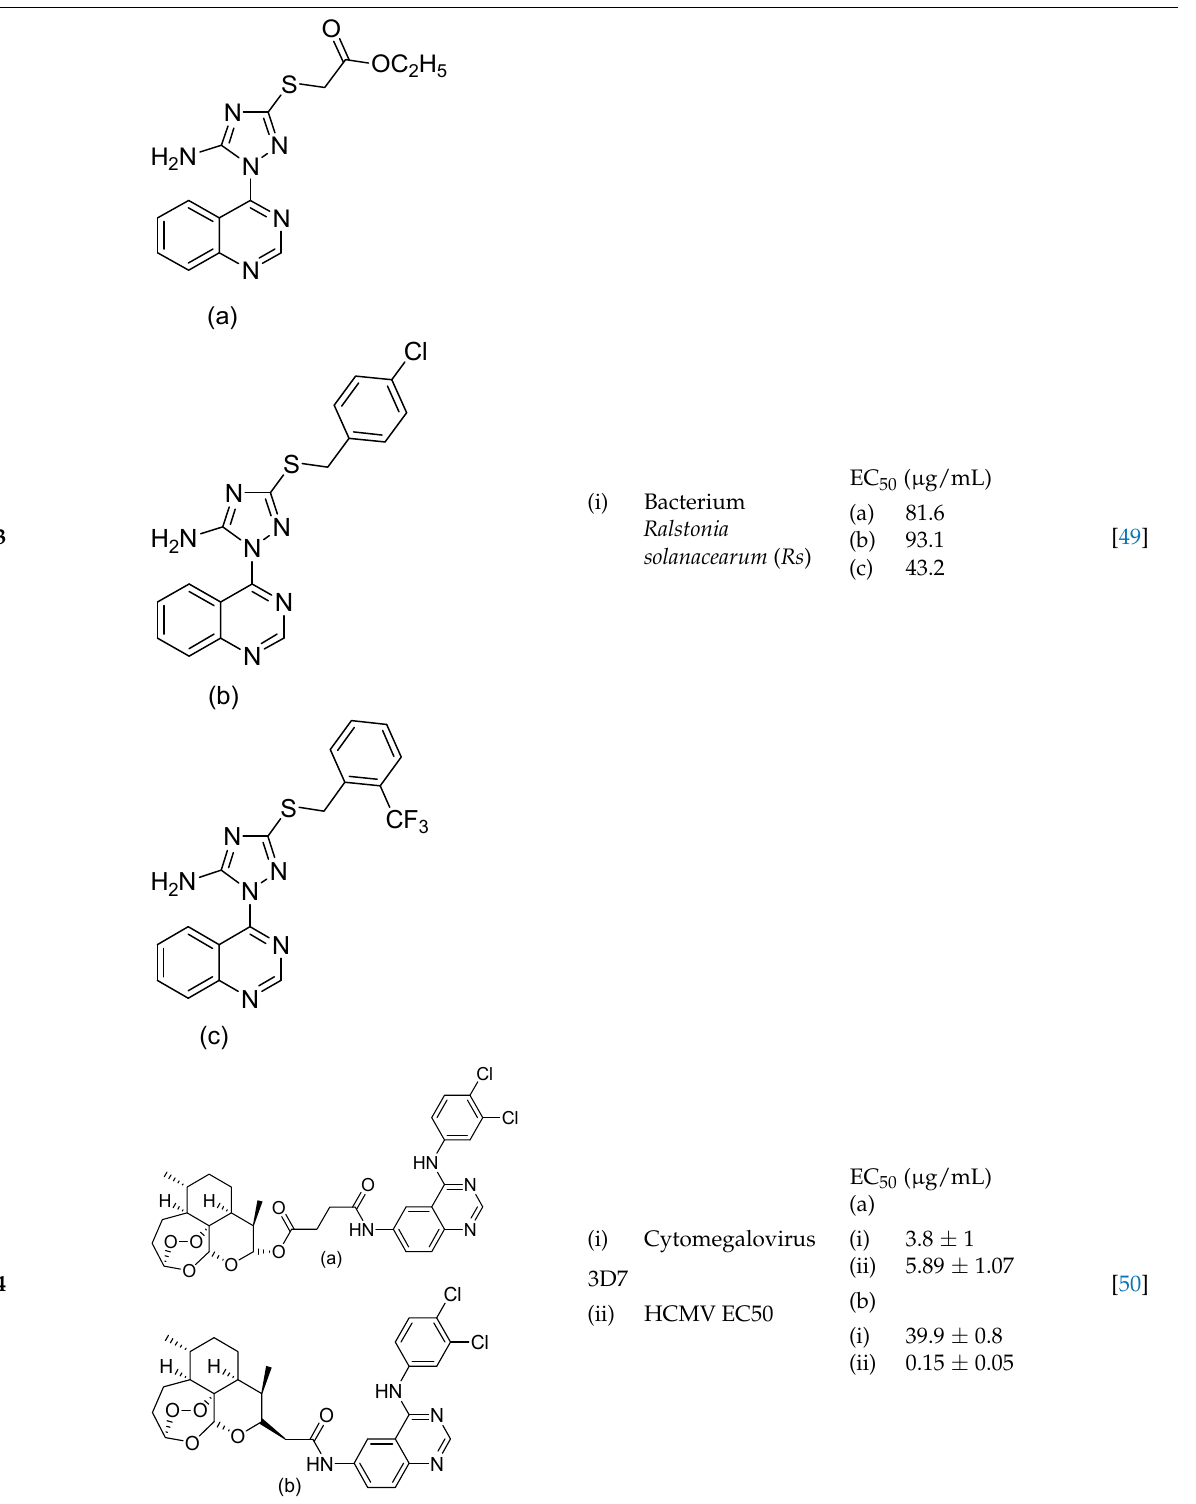
Compound no. Structure Microbe Selected Activity